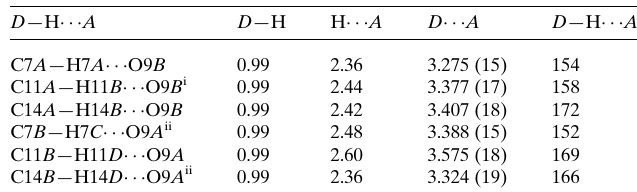
Table 1 Hydrogen-bond geometry (A˚ , (cid:3)